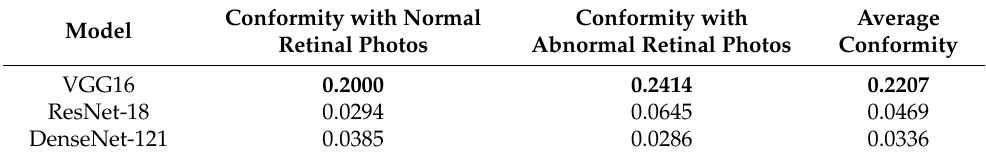
Table 5. Model conformity